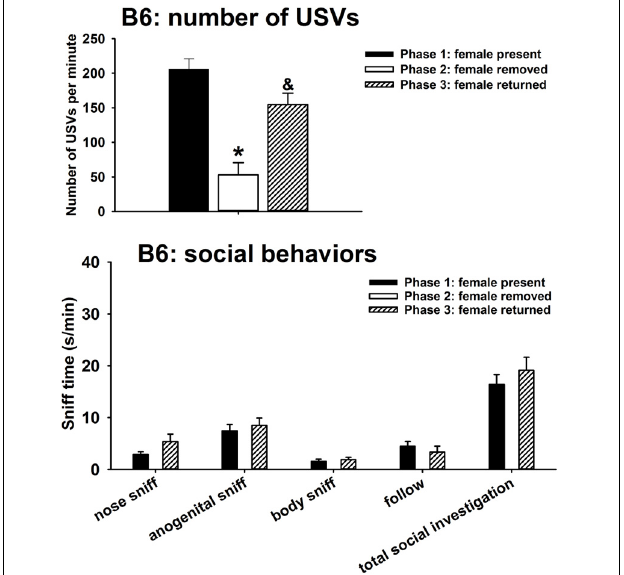
FIGURE 1 | USVs and social behaviors in B6 males during the first interaction with the female (phase 1), absence of the female (phase 2), and second interaction with the female (phase 3). USVs were detected from 12 out of 12 B6 in phase 1, 4 out of 12 B6 in phase 2, and 10 out of 10 B6 in phase 3. All animals were included in call number analysis and behavioral comparisons. B6 emitted fewer USVs in phase 2 than in phase 1, and more in phase 3 than in phase 2. Analysis of behavioral parameters revealed no significant differences between phase 1 and phase 3, on durations of nose-to-nose sniffing, anogenital sniffing, body sniffing, follow, and total social investigation. ∗ p < 0 . 05 vs. phase 1; & p < 0 . 05 vs. phase